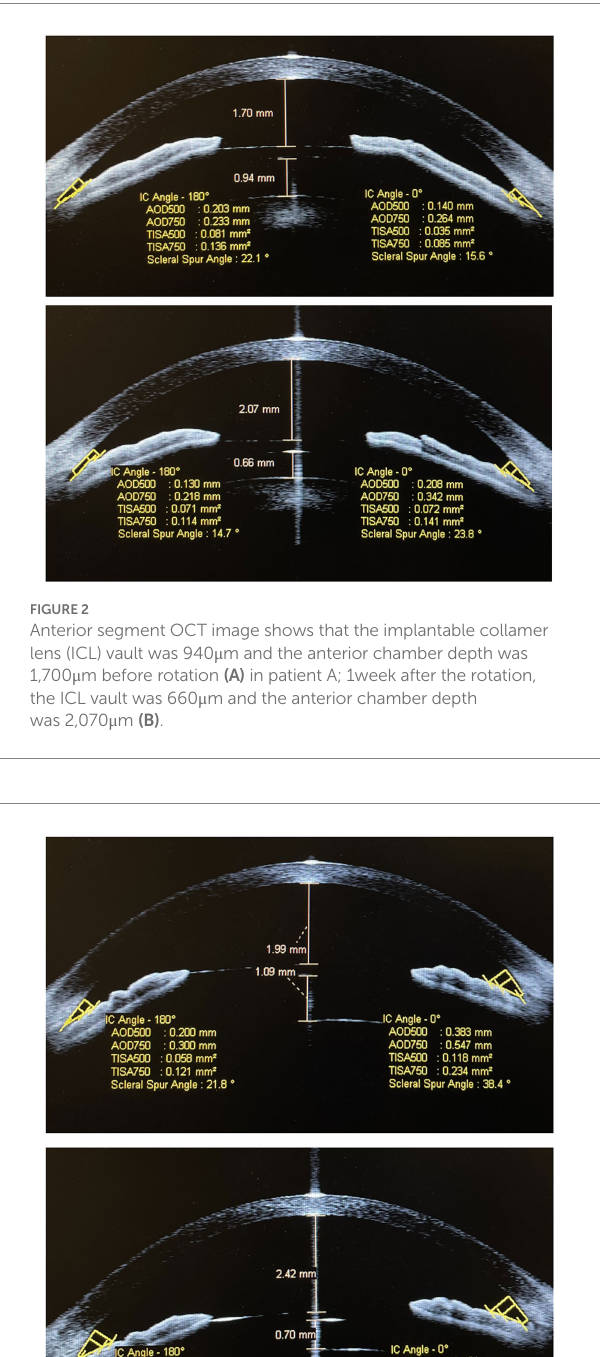
WTW distance method because the ICL haptic footplates are located